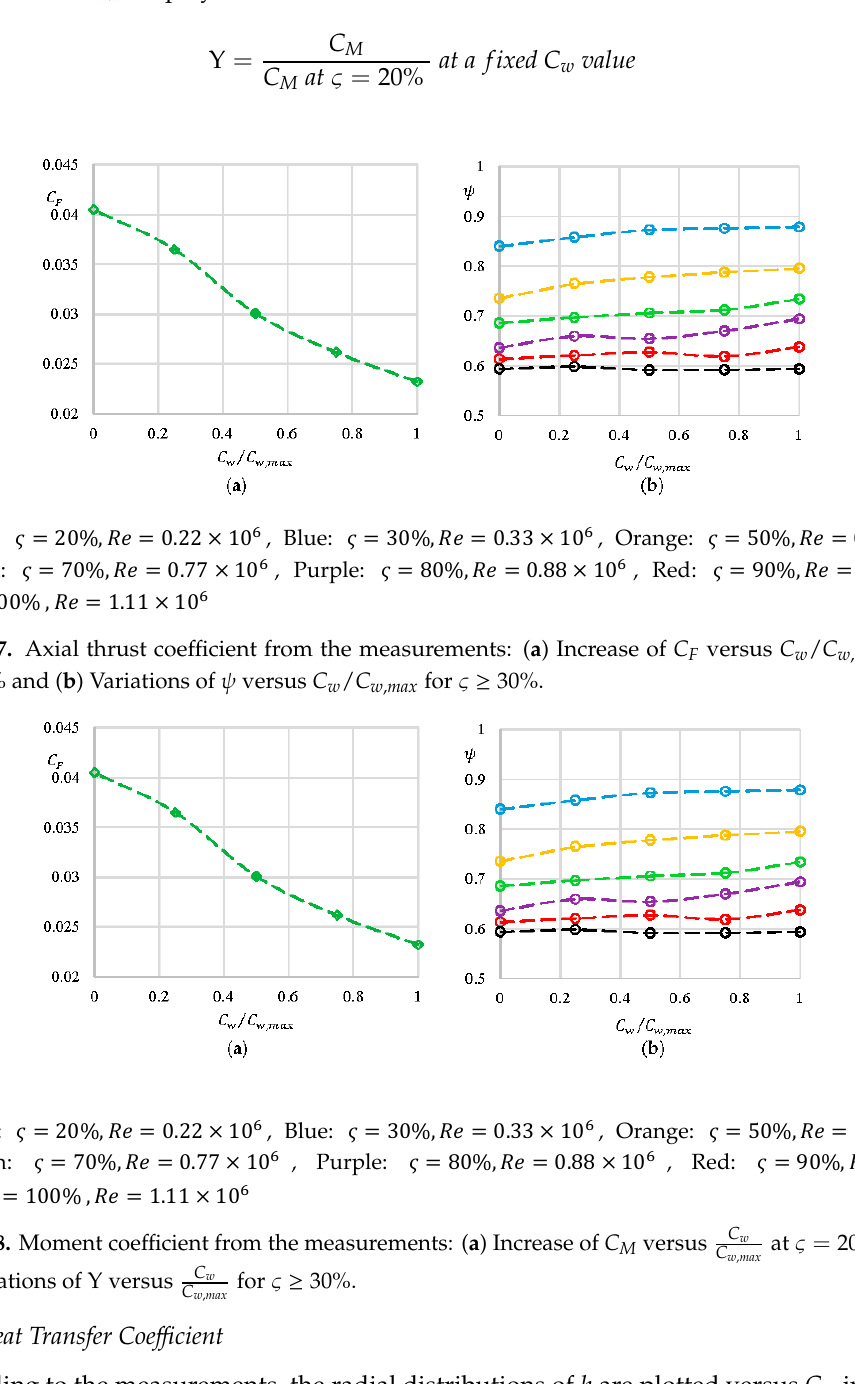
at ς = 20% and C w , max